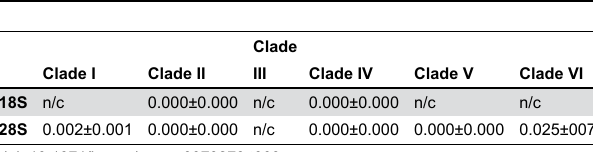
Table 2. Primers used for amplification and sequencing of 18S and 28S rRNA genes.